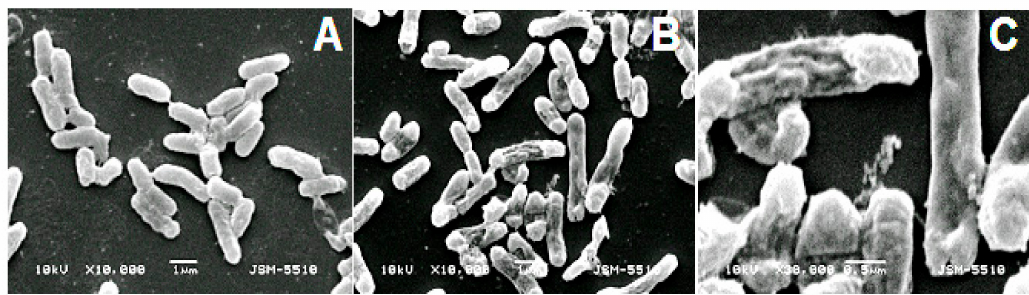
Figure 5. Illustration of antibacterial e ff ect of peptide fraction 5 on the cells of E. coli : ( A ) Control, 18 h culture of E. coli in nutrient broth; ( B ) Damaged membranes and deformation of cell of 18 h culture of E. coli in nutrient broth after 1 h action of peptide fraction 5: 10,000 × ; ( C ) Damaged membranes and deformation of cell of 18 h culture of E. coli in nutrient broth after 1 h action of peptide fraction 5, Magnification 30,000 × . The images in Figure 5 are representative micrographs from at least three independent